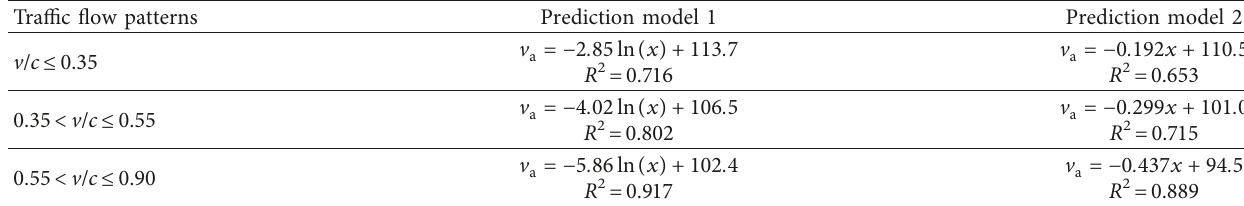
Table 3: Traffic flow average speed prediction model for the mixing rate of large vehicles.